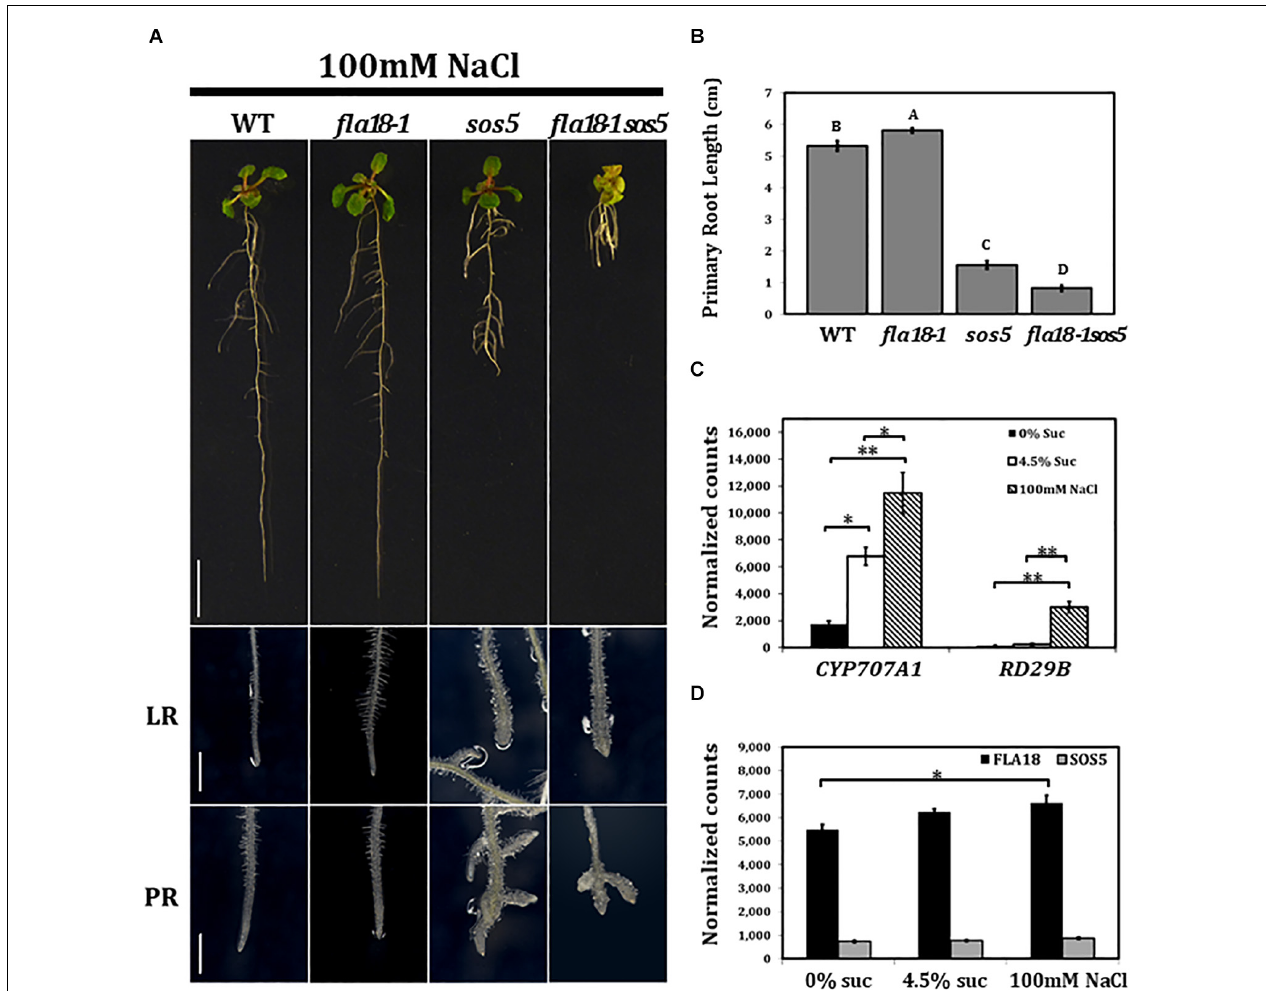
FIGURE 3 | fla18sos5 double mutants impart a synergistic effect on root elongation under salt stress conditions. Seedlings of the indicated genotypes were grown on MS medium containing 1% sucrose, for 4 days, and then transferred to medium containing 1% sucrose and 100 mM NaCl for an additional 7 days. (A) Whole seedlings (upper panel), lateral root tips (LR, middle panel) and primary root tips (PR, lower panel). (B) Measurements of primary root length were conducted 7 d after seedlings were transferred to restrictive conditions (MS supplemented with 1% sucrose and 100 mM NaCl). n = 6. (C,D) Gene expression of the indicated genes was examined in the PR of wild type seedlings germinated on medium containing 1% sucrose, for 4 days, and then transferred to medium containing either no sucrose, 4.5% sucrose or 1% sucrose + 100 mM NaCl, for 6 h. Gene expression was measured using nCounter NanoString technology, in four biological replicates. Expression level is indicated by normalized counts, as calculated by the nSolver platform using GAPC , UBQ10 , EF1a , F-BOX, and AP2 as reference genes. The results were analyzed using JMPpro13 for statistical analysis and analyzed using Tukey’s HSD (honestly significant difference) test (*p < 0.05, ∗ * p < 0.001 ). Scale bars = 1 cm ( A ; upper panel) and 1 mm ( A ; middle and lower